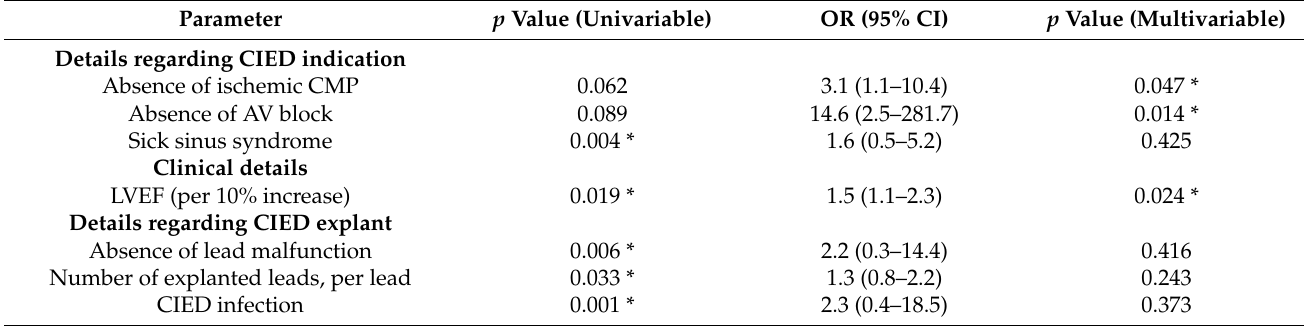
Table 2. Univariable and multivariable analysis assessing the role of clinical parameters in predicting the absence of reimplantation. Parameter p Value (Univariable) OR (95% CI) p Value